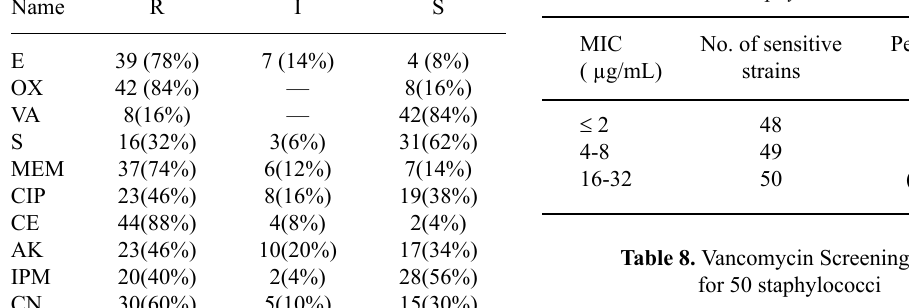
table 7. MIC of vancomycin for 50 isolates